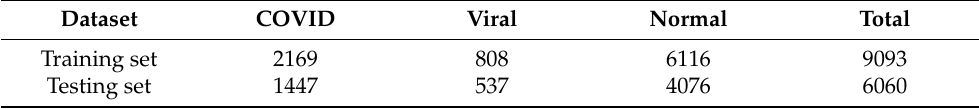
Table 2. Detailed information about the COVID-19 Radiography database.